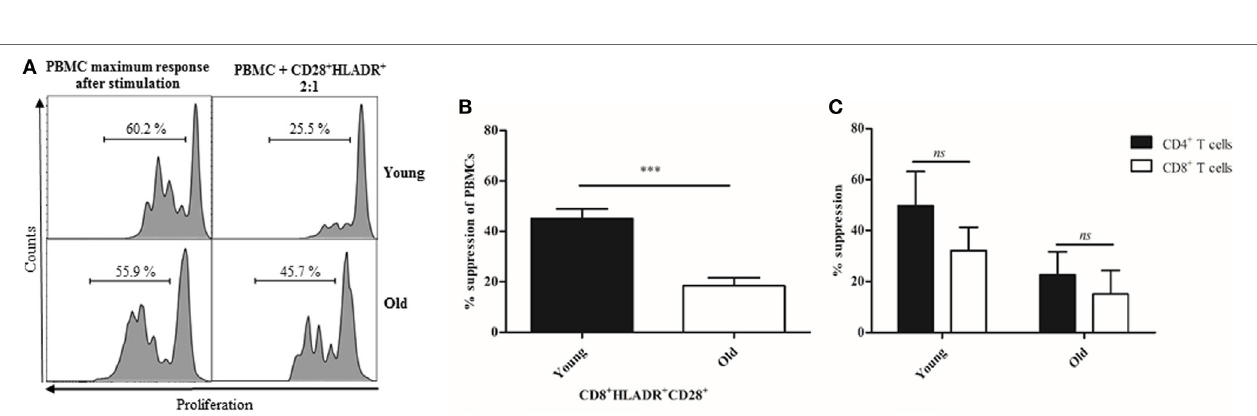
FigUre 8 | CD8 + human leukocyte antigen–antigen D related (HLADR) + CD28 + T cells suppressor properties decrease with age. (a) Representative histograms showing the suppressive activity of sorted CD8 + HLADR + CD28 + T cells from one young and one old donor on CFSE-labeled peripheral blood mononuclear cells (PBMCs) assessed in co-culture 4 days after stimulation with anti-CD3 (1 µg/ml) and anti-CD28 (0.5 µg/ml). (b) Suppressive effect of CD8 + HLADR + CD28 + T cells on the proliferation of CFSE-labeled autologous PBMCs (ratio 2:1); mean ± SEM, young donors n = 5 ( < 30 years), old donors n = 6 ( ≥ 70 years); *** p < 0.001. (c) Suppressive effect of CD8 + HLADR + CD28 + T cells on the proliferation of CD4 + vs CD8 + T cells within the CFSE-labeled PBMCs (ratio 2:1); mean ± SEM, young donors n = 2 ( < 30 years), old donors n = 4 ( ≥ 70